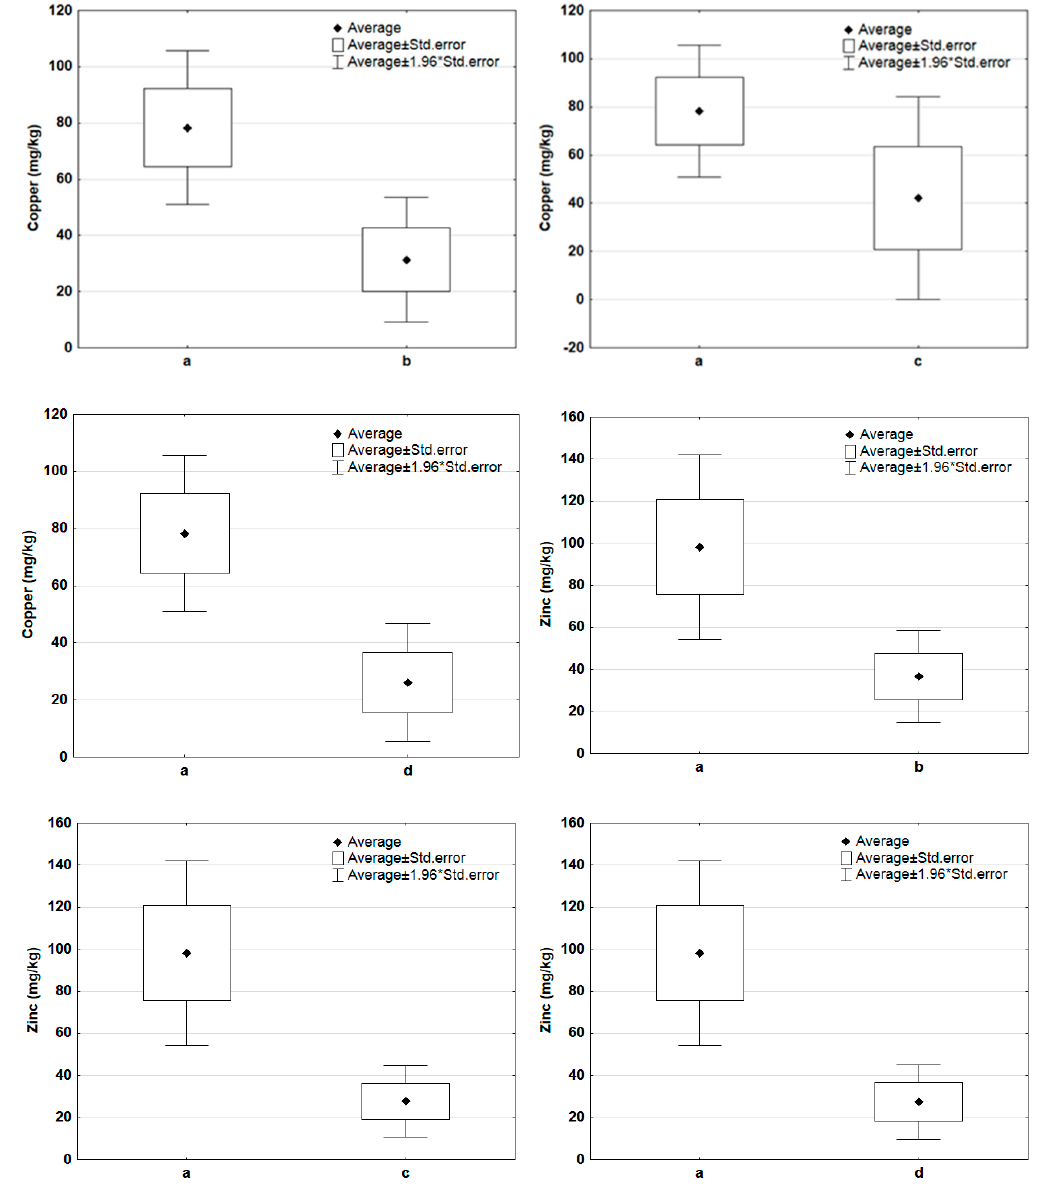
Figure 7. Comparison of basic statistics (mean, standard error) for copper and zinc content in the tested sample groups ( a —new samples, b —composted samples without irradiation, c —composted samples irradiated for 20 h, d —composted samples irradiated for 50 h).